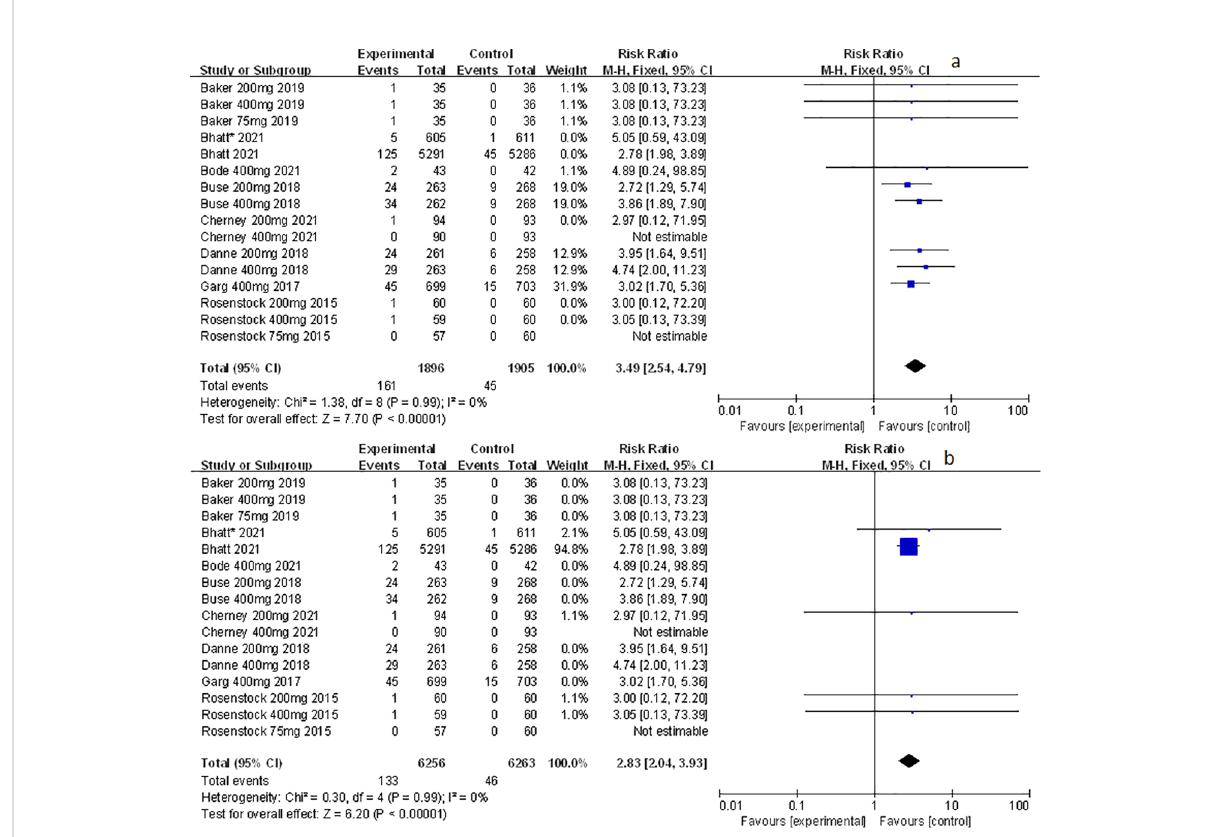
FIGURE 1 Forest plots of genital mycotic infection for sotagli fl ozin versus the control group in T1D and T2D. (A) The adverse events of genital mycotic infection in T1D. (B) The adverse events of genital mycotic infection in